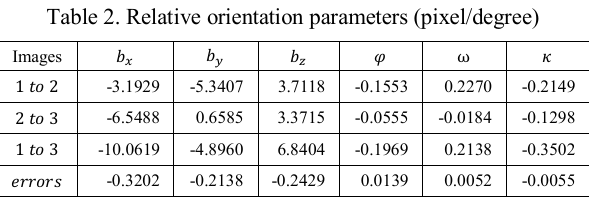
Table 3. Relative orientation errors (pixel/degree)